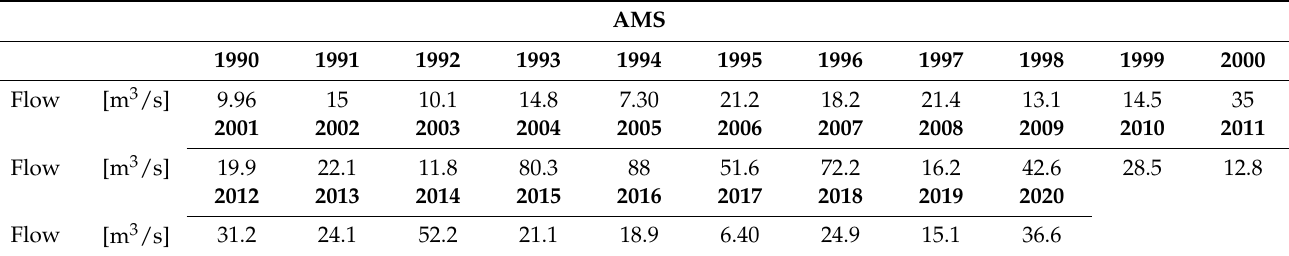
Table 4. The AMS from the Prigor hydrometric station.